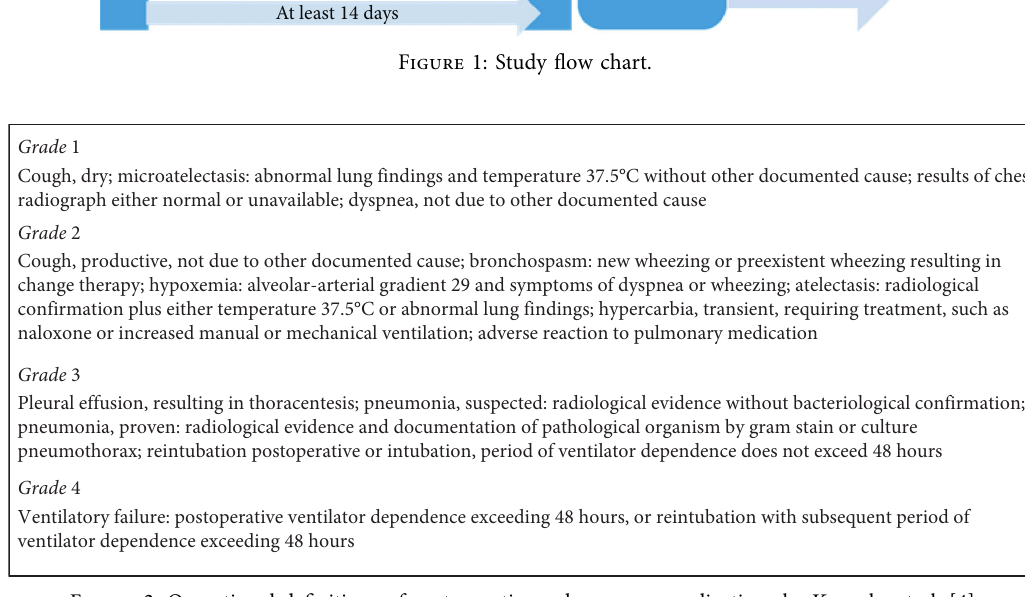
Figure 2: Operational definitions of postoperative pulmonary complications by Kroenke et al.